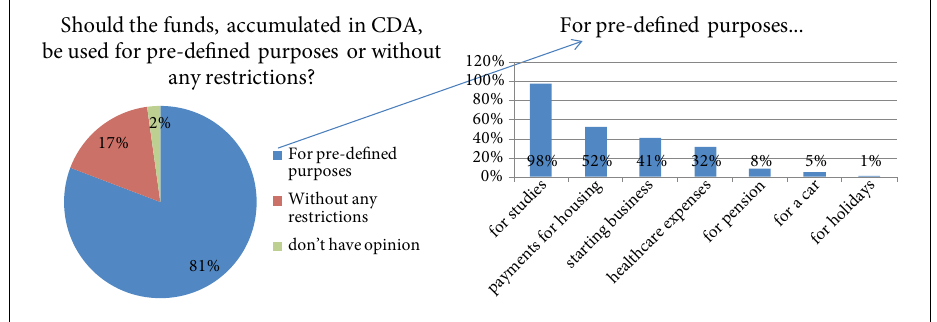
Should the funds, accumulated in